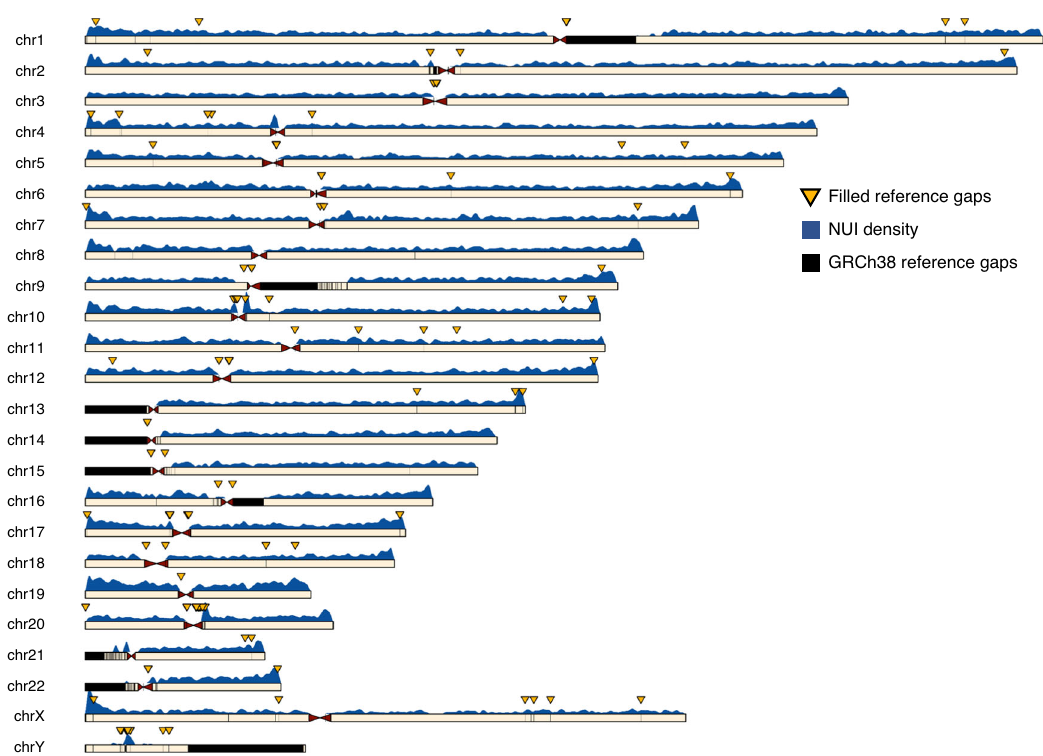
Fig. 1 Overview of NUI distributions. Ideogram illustrating the distribution of NUIs in the 24 chromosomes. Black chromosomal segment refers to GRCh38 reference gaps and yellow down pointing arrows indicate gaps that can be fully closed or minimized with our pipeline. The blue density plot above the chromosomes depicts the number of NUIs identi fi ed using a sliding window of 1 Mb with a 10-kb step